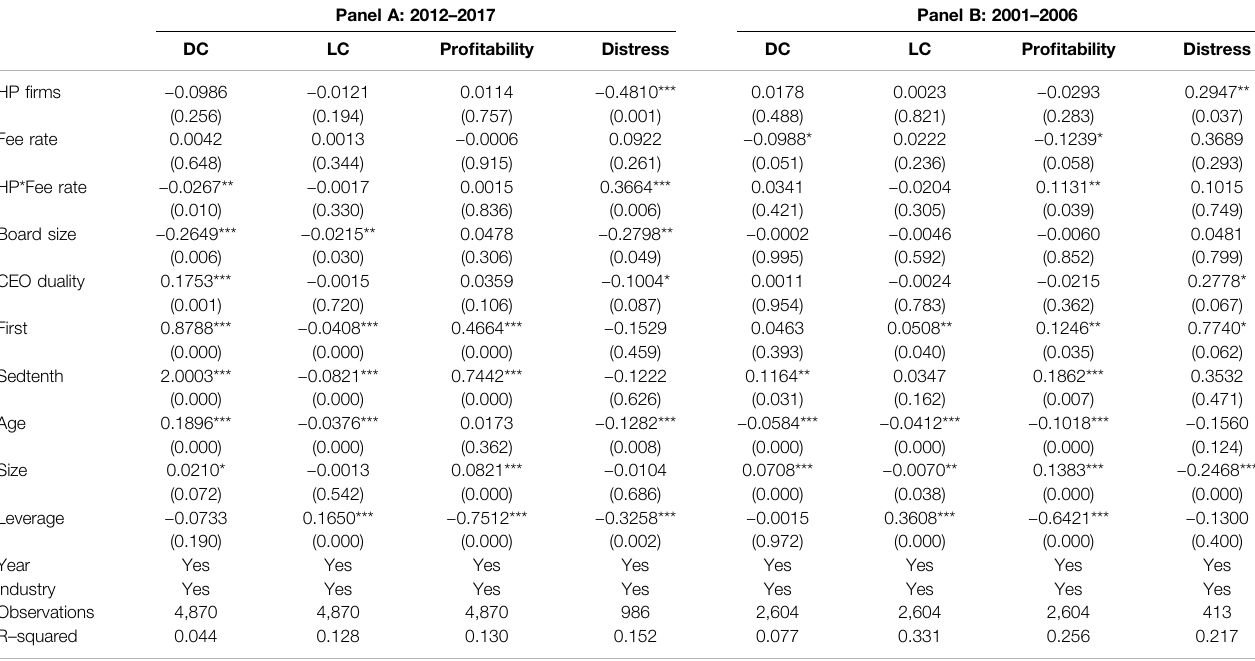
TABLE 7 | Robustness test-environmental protection fee rate. Thistablepresentstheresultsofrobustnesstest-environmentalprotectionfeerate.TheenvironmentalprotectionfeerateisadoptedtoreplaceAfterandre-estimatethe in fl uence of environmental protection fee on fi rm performance. There are different fee rates for various water and gas pollutants. We apply all water and gas fee rates to replaceAfterandachievesimilarresults.Forbrevitypurpose,weonlyreporttheresultsofwaterfee.Fortheprobitregression(columnDistress),wereportthemarginaleffect rather than the coef fi cients. For the de fi nitions of variables refer to Appendix A . P -values are in parentheses.